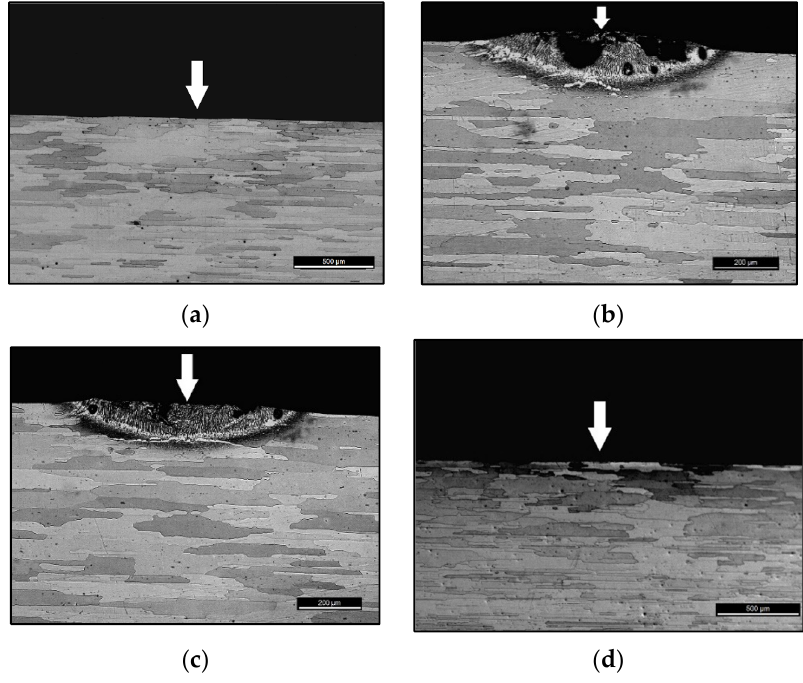
Figure 2. Light optical micrographs of cross sections of heating lines produced with laser power of 200 W and displacement speeds of: ( a ) 1 mm/s; ( b ) 2.5 mm/s; ( c ) 5 mm/s; ( d ) 10 mm/s (etchant: Keller). The arrows indicate the beam axes.